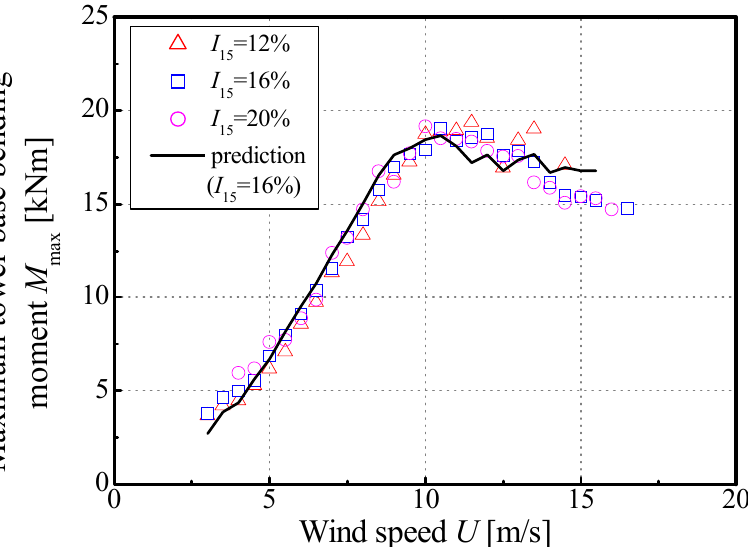
Fig. 5 Maximum tower base bending